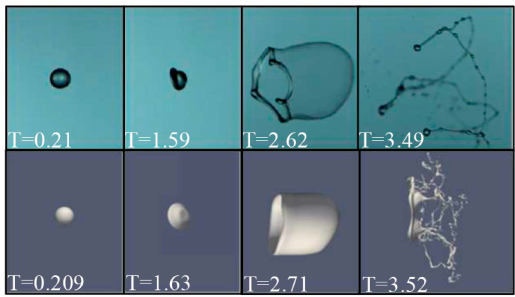
Figure 6. Comparison of the numerical results with experimental results for droplet bag